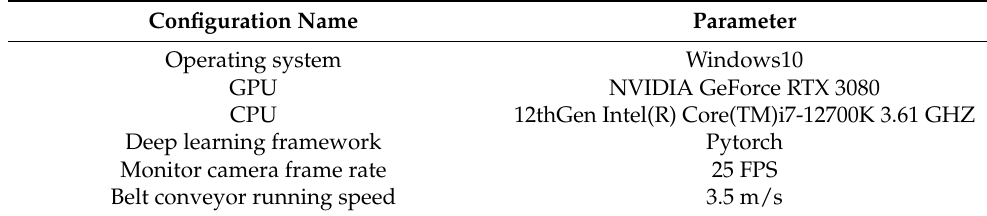
Table 1. Parameters of Software equipment and hardware